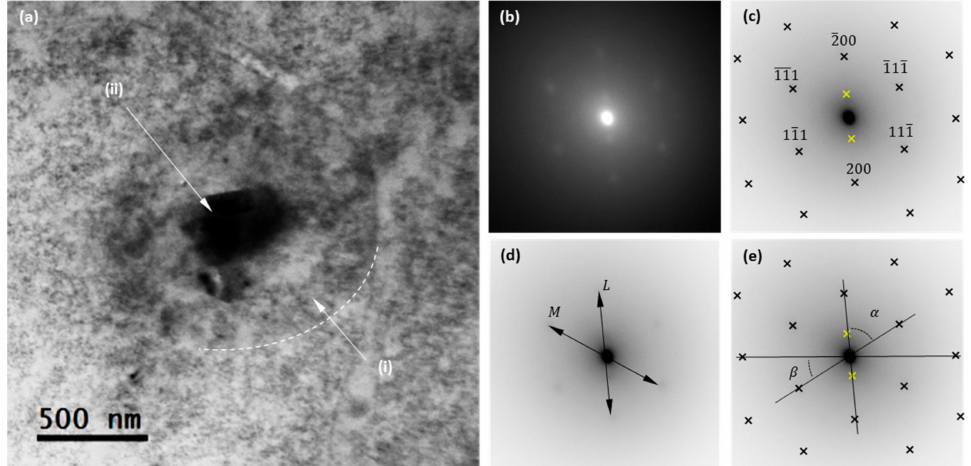
Figure 3. ( a ) Transmission Electron Microscopy (TEM) bright field overview of a single nanoparticle; dark contrast indicates the TiO 2 core, while the weaker dark contrast surrounding the nuclei